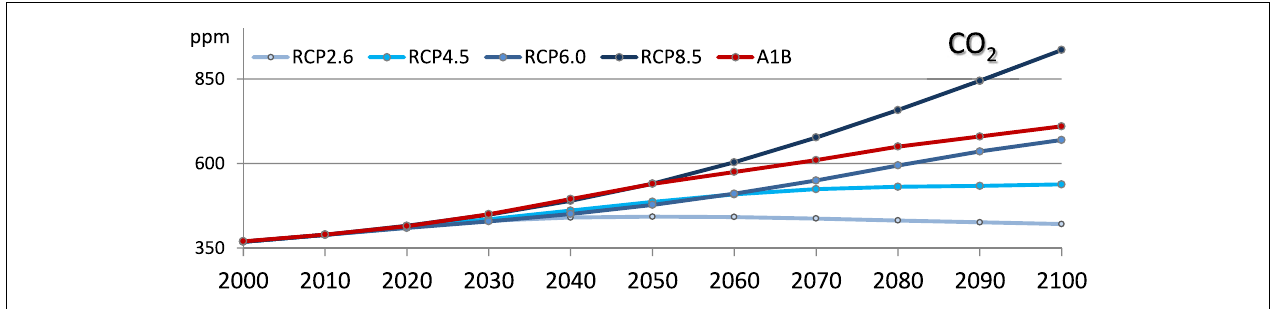
FIGURE 9 | Possible RCP [CO 2 ] pathways compared to the SRES A1B scenario. RCP Data was taken from the RCP-Database (Kolp and Riahi, 2013).